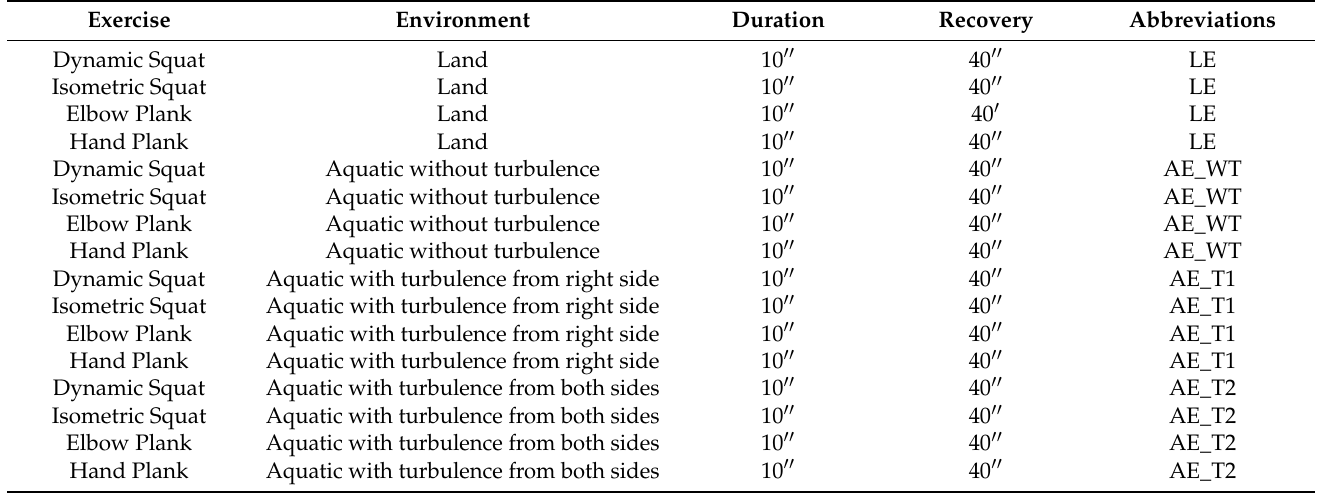
Table 1. Exercise